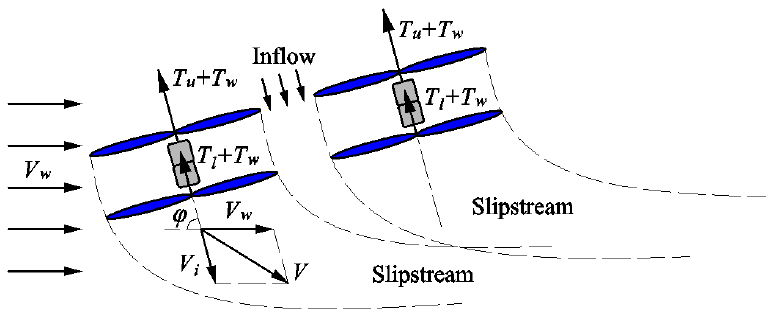
Figure 3. Aerodynamic model of adjacent coaxial rotor pairs with wind disturbance.